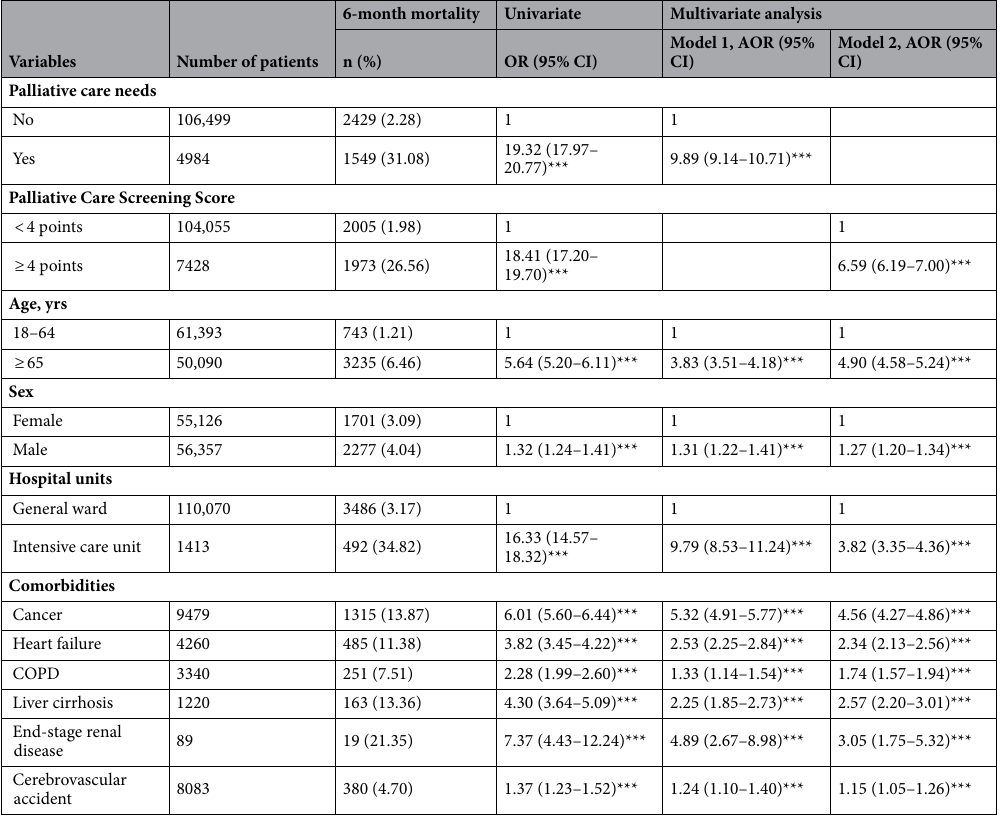
Table 2. Univariate and multivariate analyses of factors associated with 6-month mortality among patients. *** < .001. AOR, adjusted odds ratio; CI, confident interval; COPD, chronic obstructive pulmonary disease.